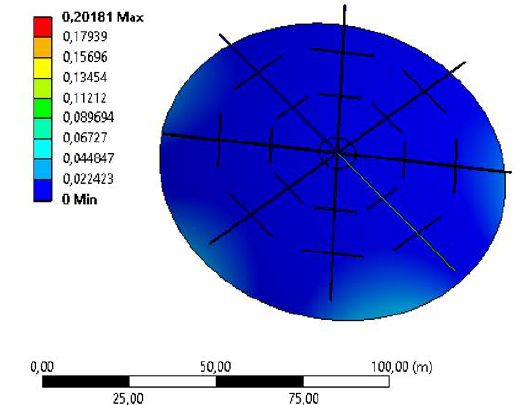
Fig. 3. Total displacements of the transformable antenna reflector,